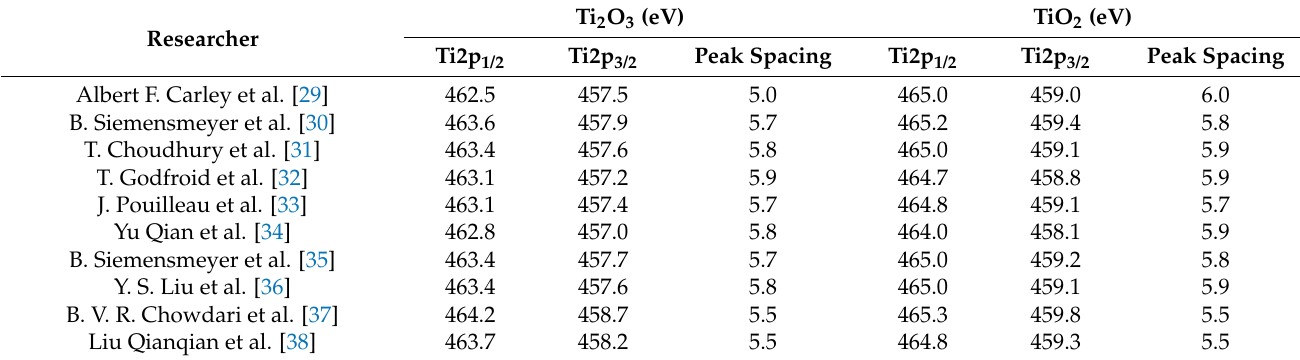
Table 3. Peak positions of photoelectron peaks of Ti 3+ and Ti 4+ in titanium oxide in the